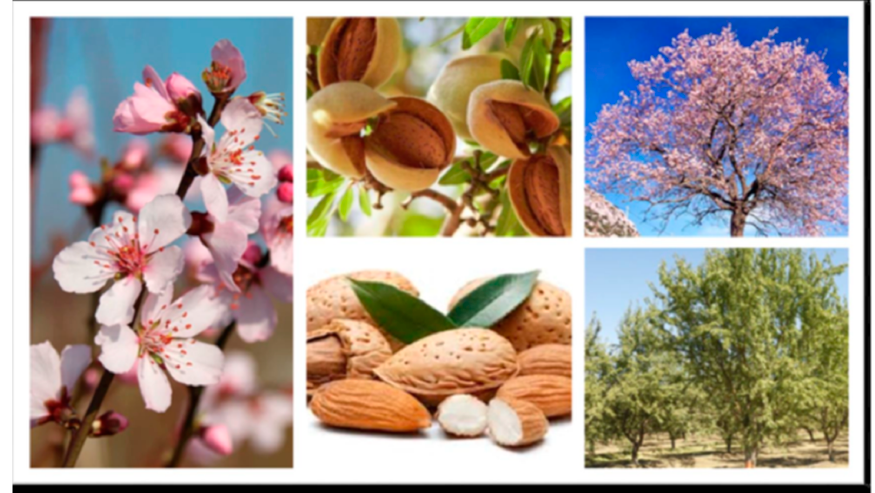
Figure 1. Photographs of Prunus dulcis trees, blooms and fruits. Almond Lifecycle: November through January: almond trees go through a period of dormancy, losing their leaves. Between mid-February and mid-March: almond trees have flowering with white and light-pink blooms.